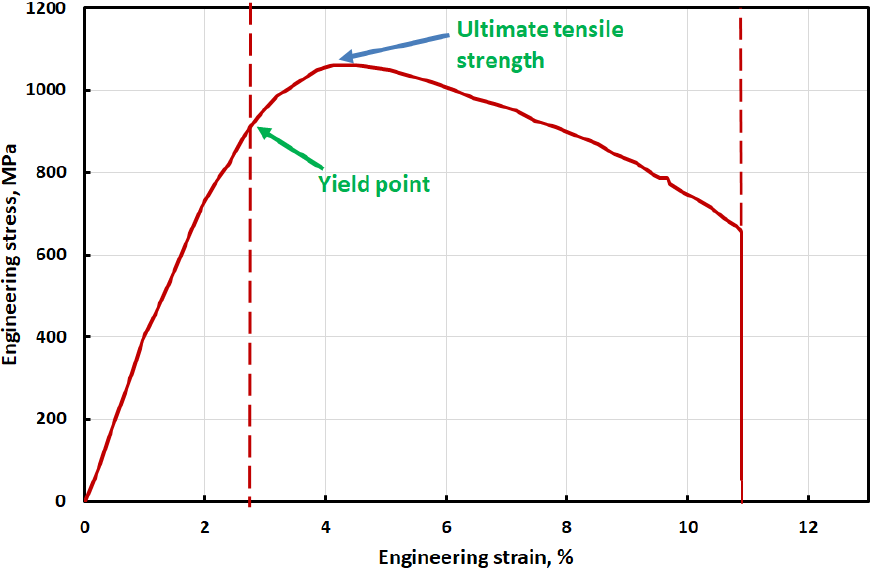
Figure 6. Engineering Stress strain curve of M9.8 sample solid solution annealing followed by WQ. Table 3. Tensile properties M9.8 sample at solid solution annealing followed by WQ.